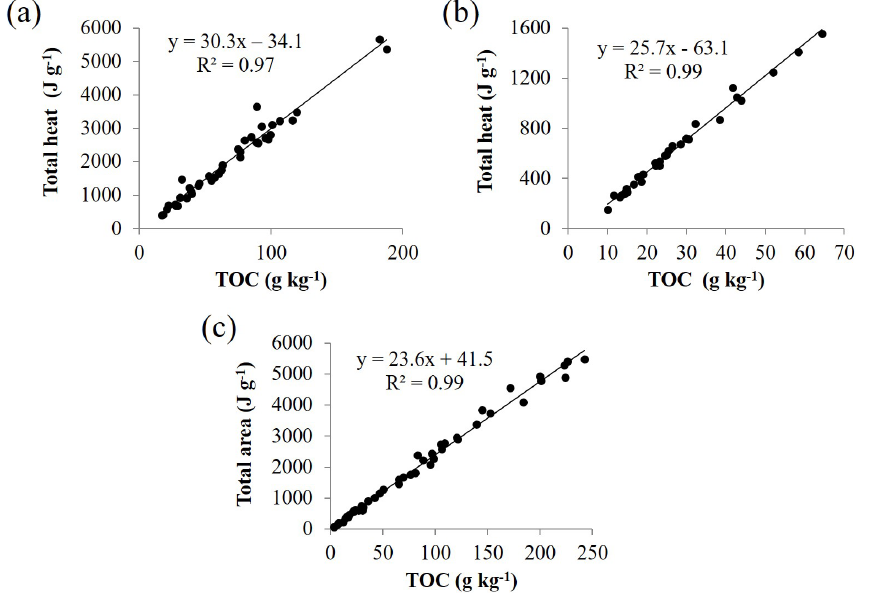
Figure 4. Total heat released between 150 and 600 ◦ C from kiln and reference soils as a function of TOC content for (a) forest soils from Belgium, (b) cropland soils from Belgium and (c) forest soils from